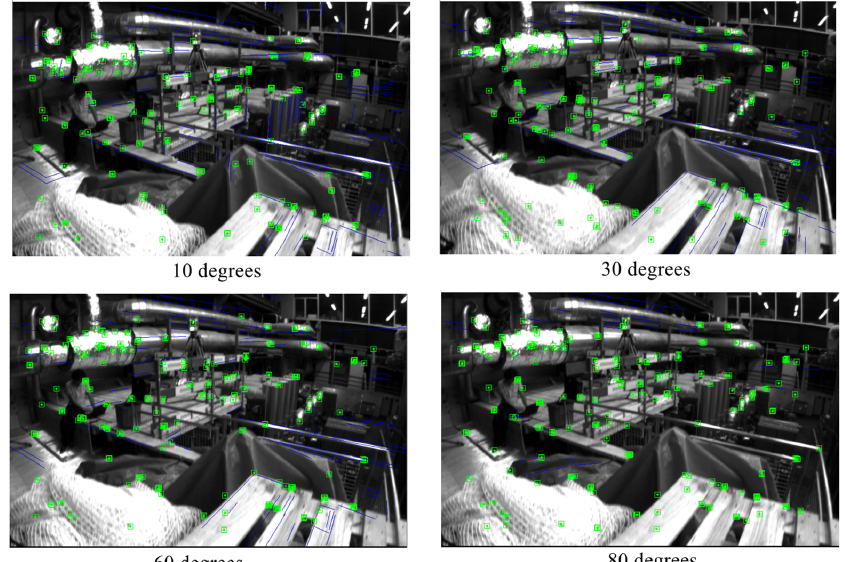
, the fewer structural lines (blue lines in the figure) 𝛼𝛼